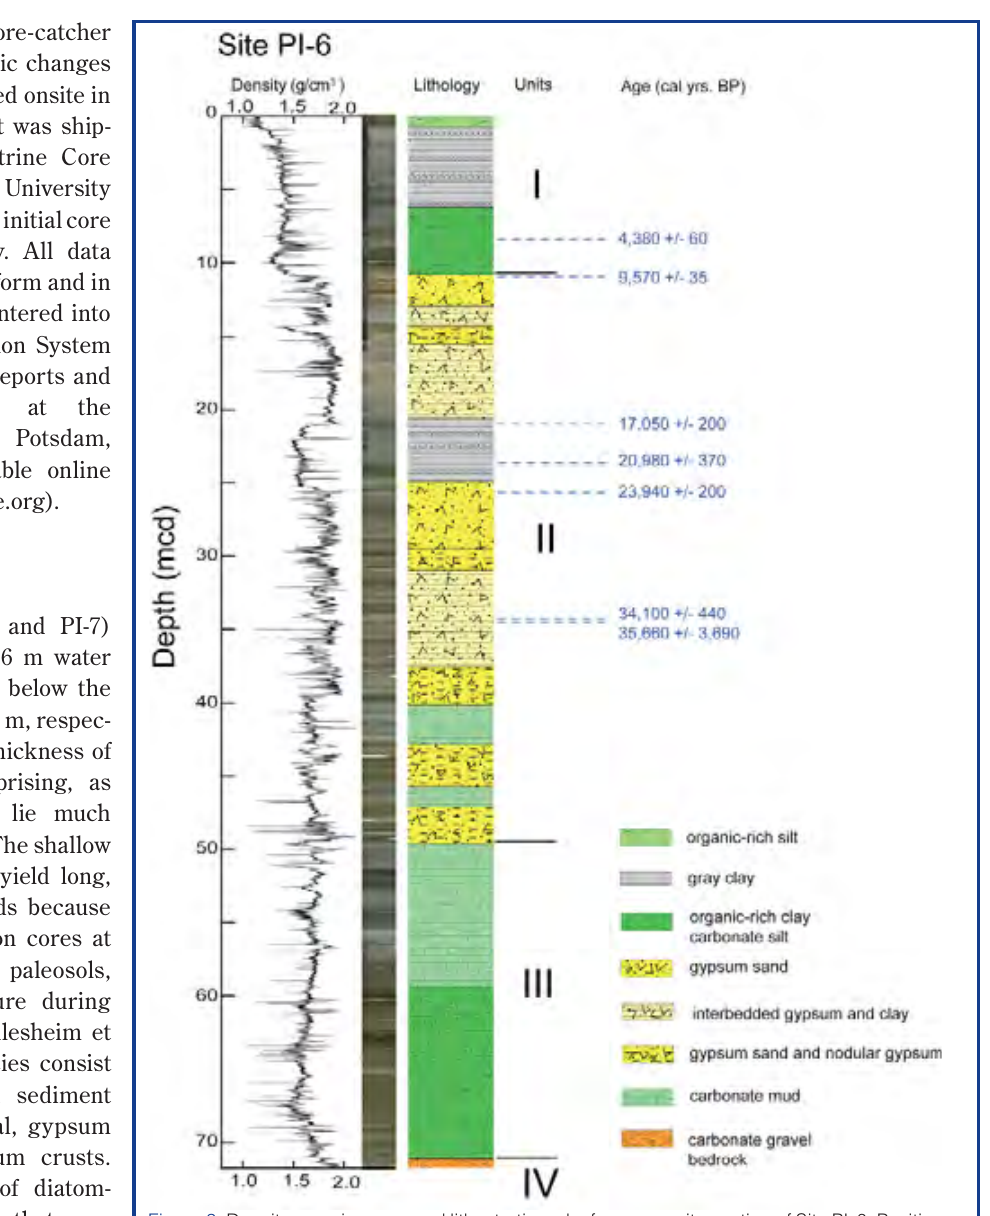
Figure 3. Density, core images, and lithostratigraphy for composite section of Site PI-6. Positions of calibrated radiocarbon dates on terrestrial organic matter are